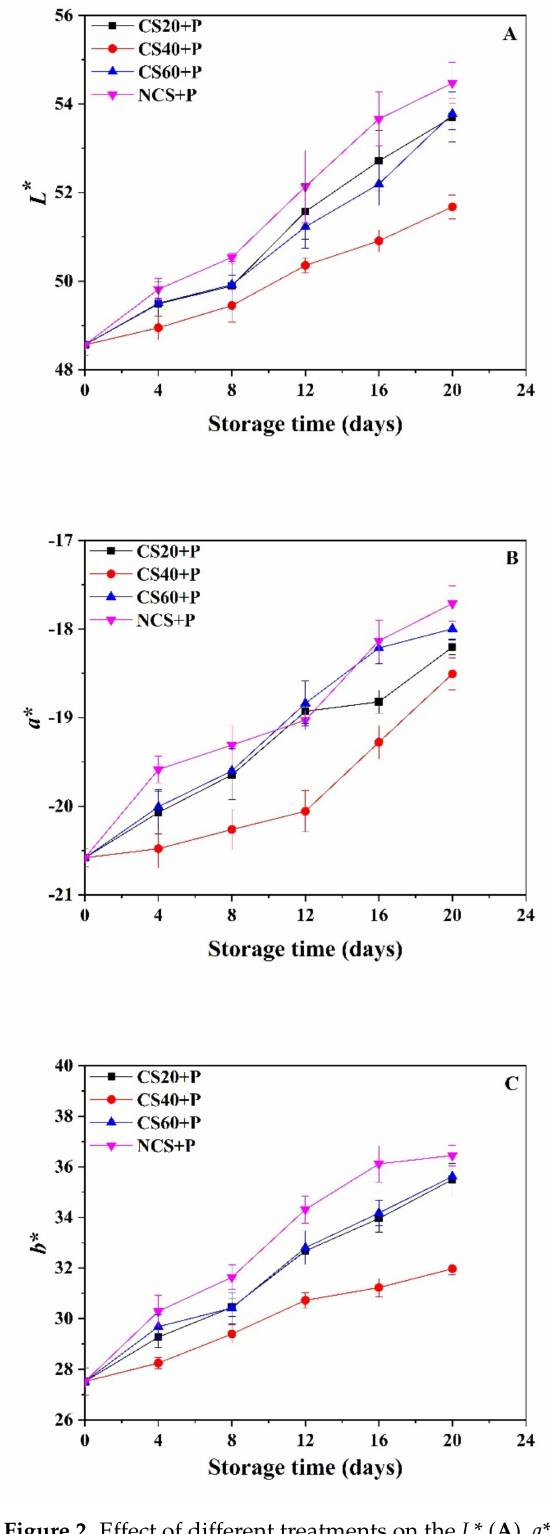
Figure 2. Effect of different treatments on the L * ( A ), a * ( B ), and b * ( C ) values of cucumbers during storage at 13 ± 2 ◦ C. CS20+P − packaged after 20 min of cold shock; CS40+P − packaged after 40 min of cold shock; CS60+P − packaged after 60 min of cold shock; NCS+P − packaged after 0 min of cold